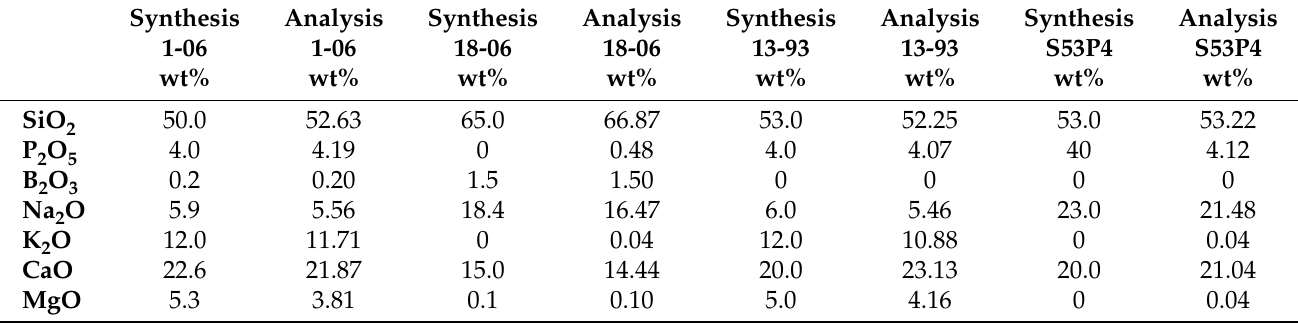
Table 3. Synthesis and analysis composition of the